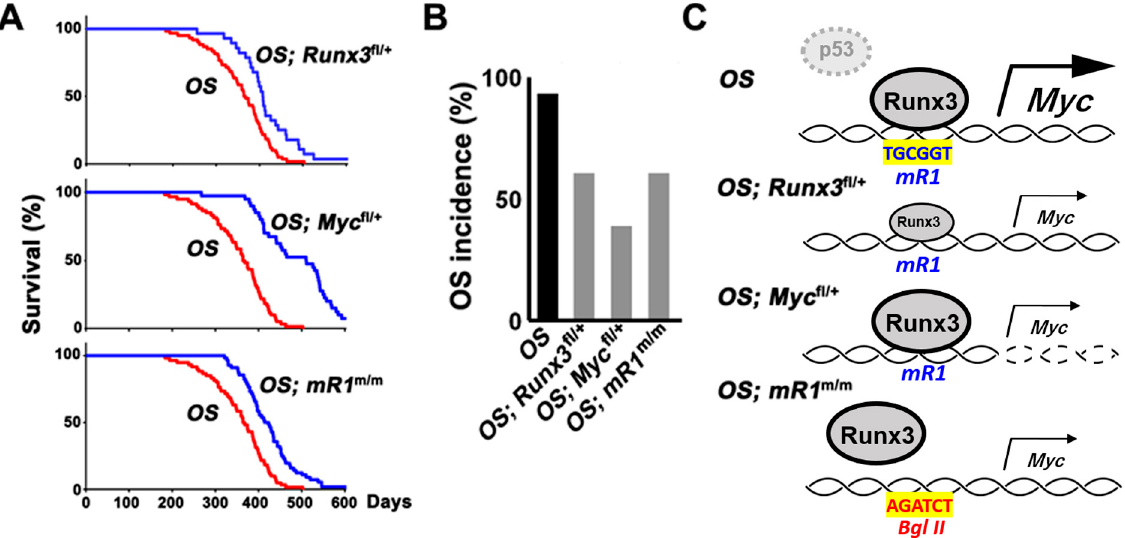
Figure 1. ( A , B ) Osx -Cre; p53 fl/fl ( OS ) mice with heterozygous deletions of Runx3 ( OS ; Runx3 fl/+ mice) or Myc ( OS ; Myc fl/+ mice) or with mR1 (a Runx consensus site, TGCGGT in the Myc promoter) homozygous mutation replaced by the Bgl II site, AGATCT ( OS ; mR1 m/m mice) show a significantly longer life span ( A ) and less incidence of OS development than the original OS mice ( B ). ( C ) Runx3 heterozygous, Myc heterozygous, or mR1 homozygous mutations produce a similar result, i.e., suppression of Myc in vivo. ( A , B ) are modified from Otani et al. (2022) [32].